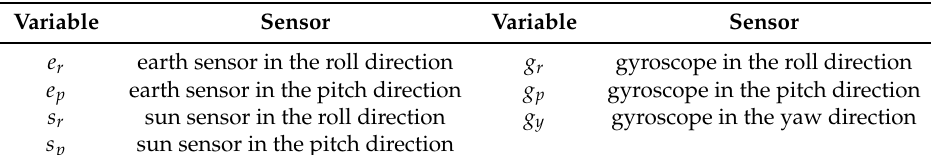
Table 5. The identification rates of various methods.